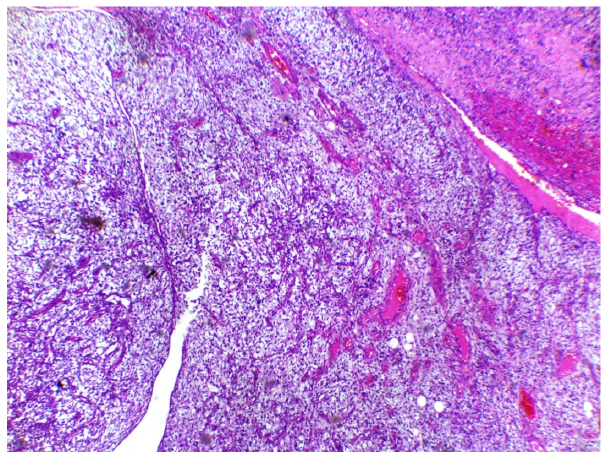
Figure 5. Histological image of the low grade fibromyxoid sarcoma showing an admixture of collagenized and hypocellular myxoid zones with arcades of small vessels.